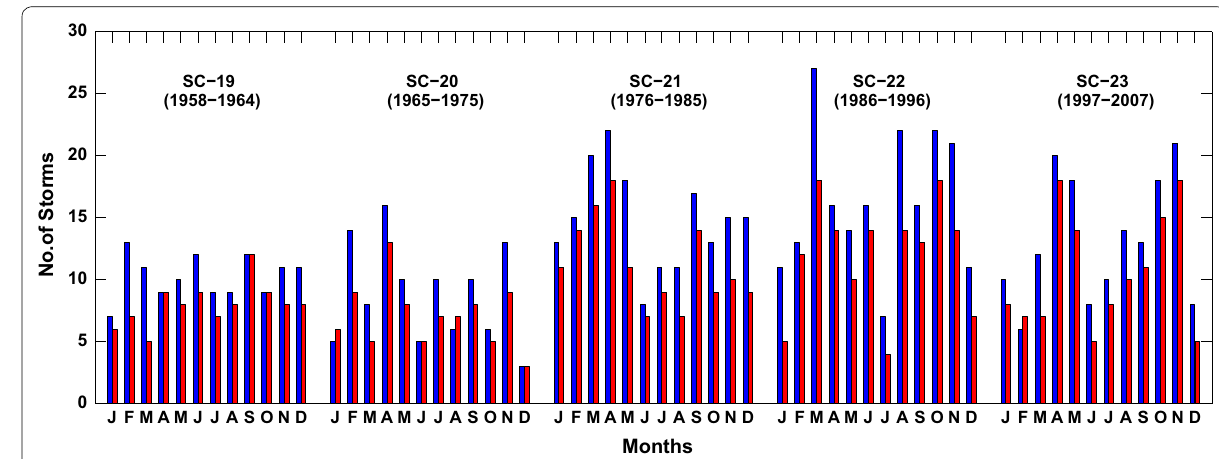
Fig. 6 Seasonal variations of number of storms in Kyoto Dst ( blue ) and USGS Dst ( red ) obtained separately for solar cycles 19–23